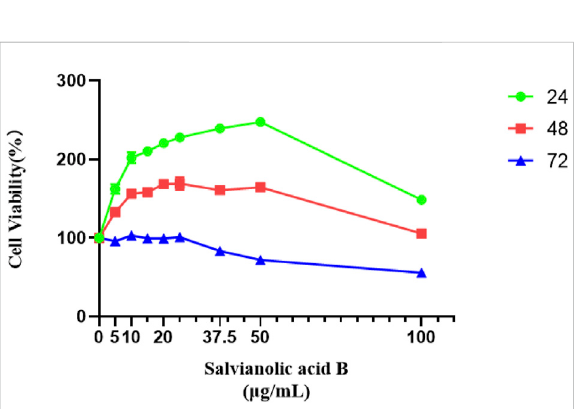
FIGURE 10 Salvianolic acid B promoted the proliferation of lymphatic endothelial cells. The image represents the viability of lymphatic endothelial cells treated with different dosages of Salvianolic acid B (5, 10, 15, 20, 25, 37.5, 50, and 100 μ g/ml). The green curve represents the cell viability after 24 h of treatment with different concentrations of SAB. The red curve represents the cell viability after 48 h of treatment with different concentrations of SAB. The blue curve represents the cell viability after 72 h of treatment with different concentrations of